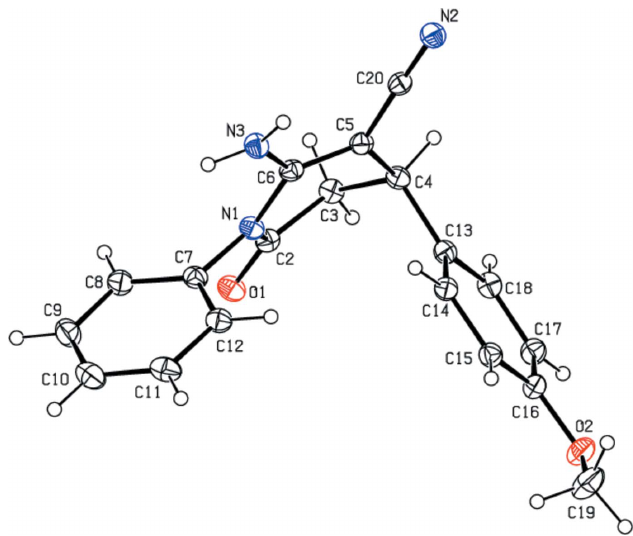
Figure 1 The molecular structure of the title compound with displacement ellipsoids drawn at the 30% probability